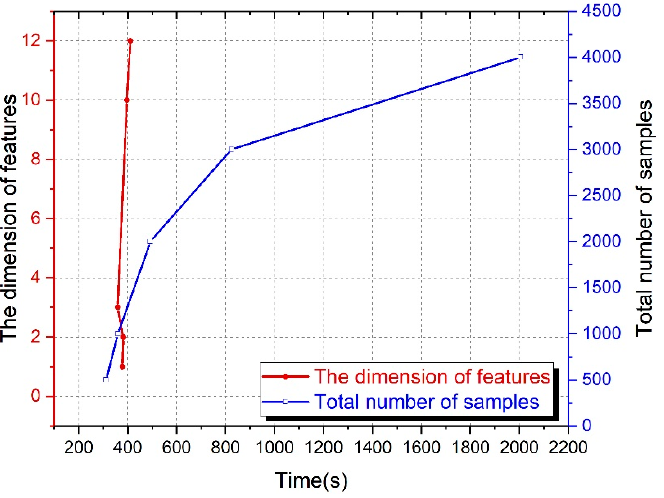
Figure 13. Time complexity of SVM.